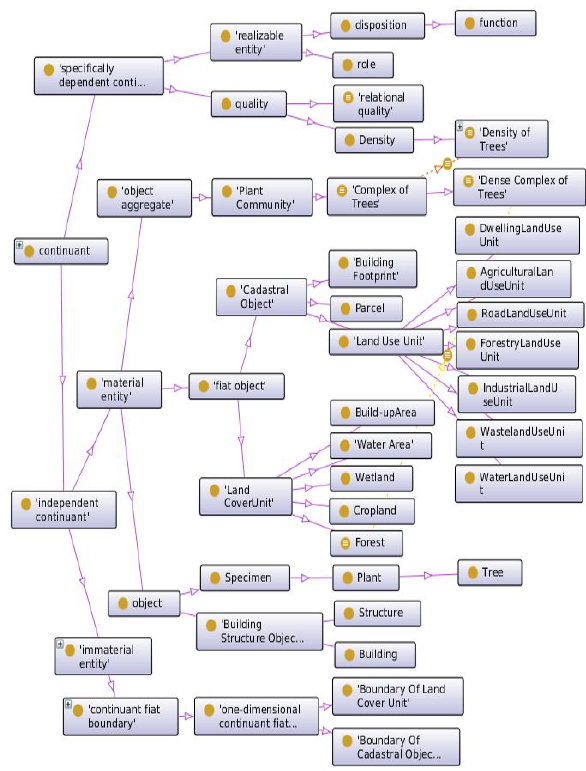
Figure 6. Extending BFO continuant classes by real world object classes representing spatial management issues Modelling using the BFO can take two strategies. The first